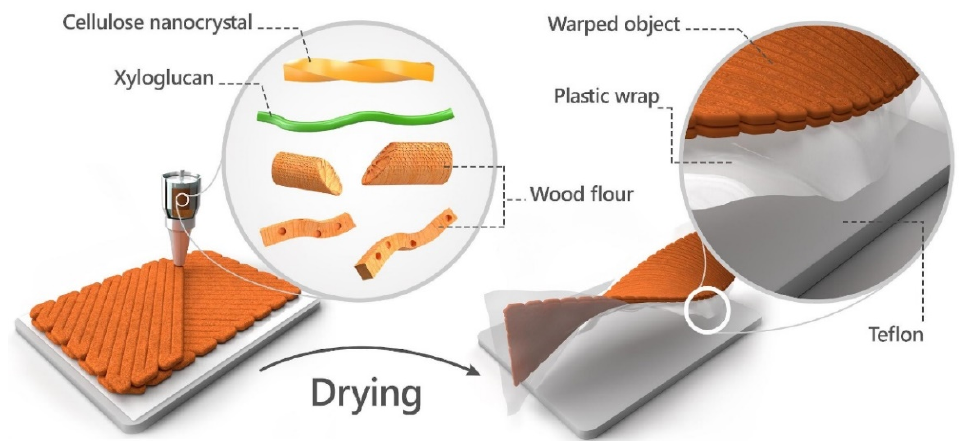
Figure 2. Schematic drawing of the printing and drying process. Wood ink consists of WF, and CNC and XG are extruded in a 2D predesign pathway on a plastic wrap placed on a Teflon substrate. The obtained object reduces its volume as a result of gradual evaporation of water and glides on the Teflon substrate. The anisotropic shrinkages result in a 3D wood warped object.